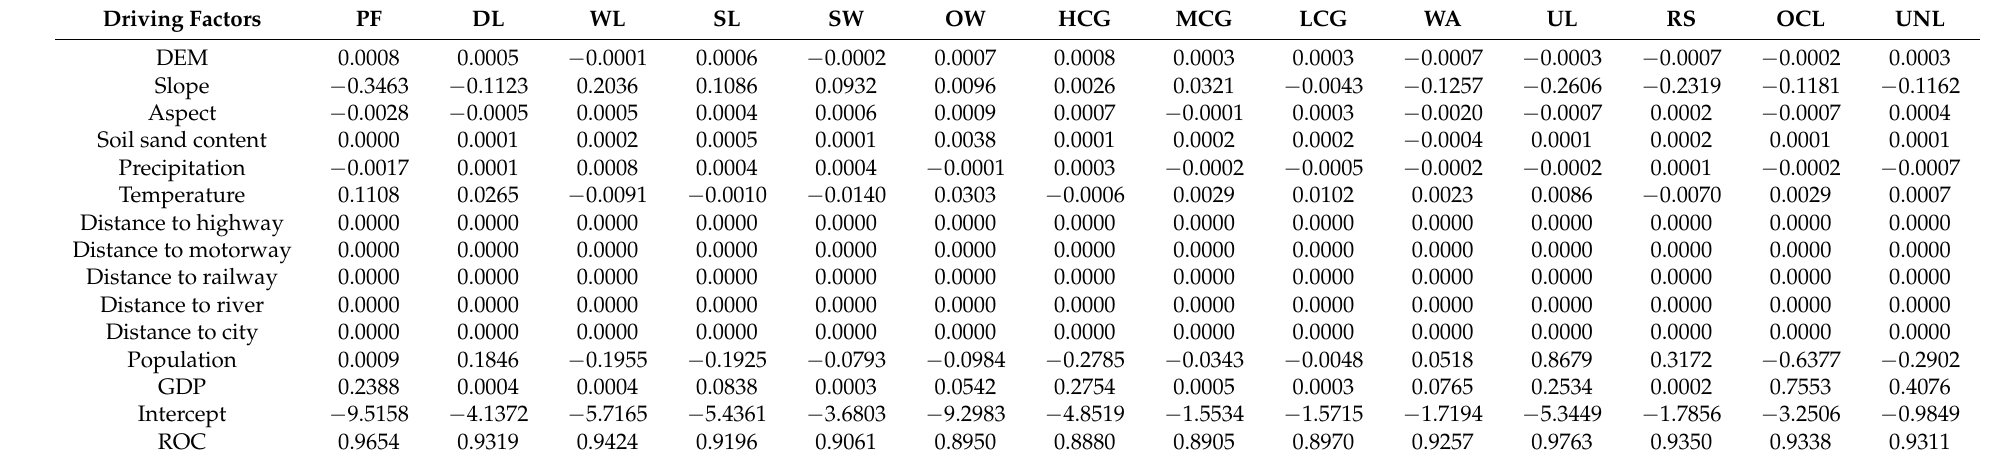
Table 3. Logistic regression coefficients and ROC test results for each land use type in the Yellow River